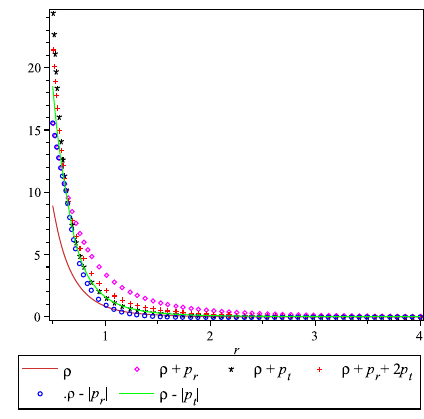
(e) This figure depicts the behavior of all EC terms for Model-I in Subcase 8 ( ξ 1 = 0, α 1 < 0, β 1 > 0, α < 0). Except DEC, all ECs are found to be satisfied for every r > 0.